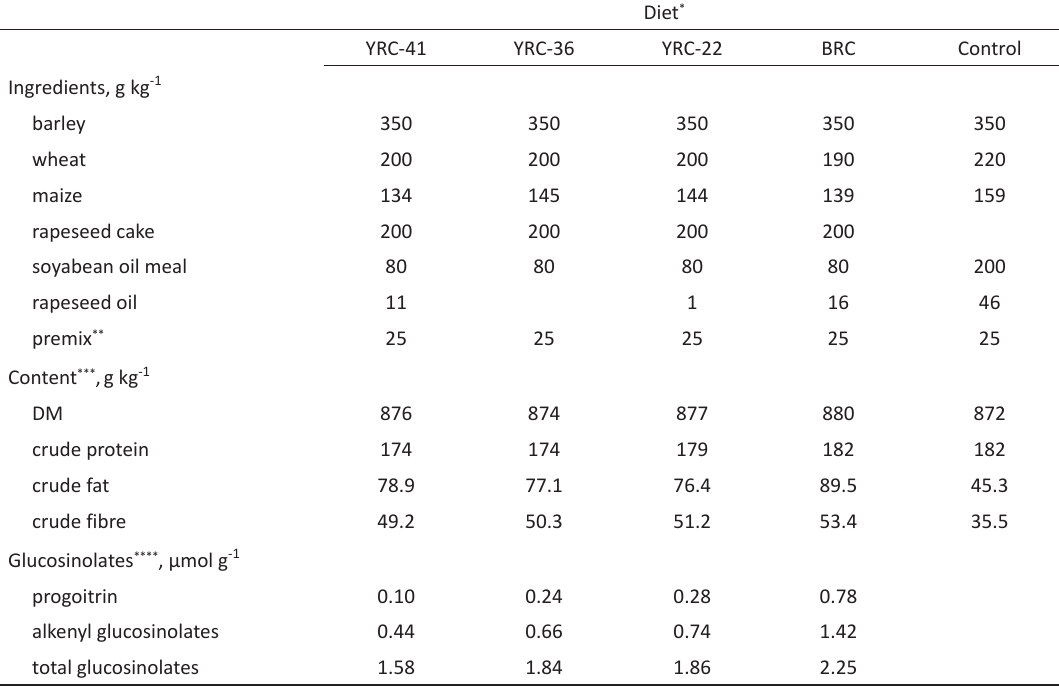
Table 2. Composition of diets used in Experiment